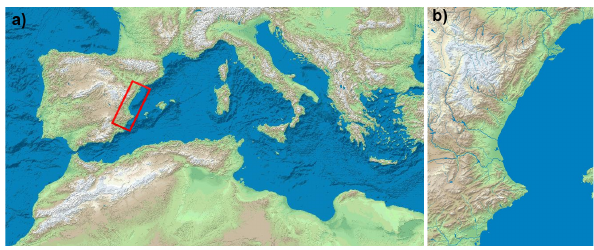
Fig. 1. Location (a) and orography (b) of Valencia region in the Mediterranean area